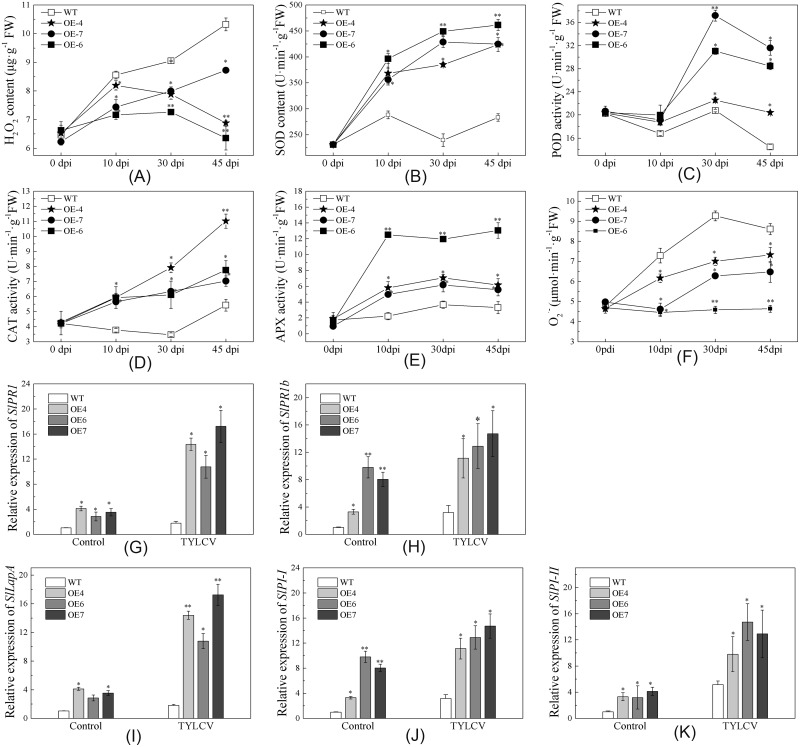
H2O2 accumulation, antioxidant enzyme activity, and defense-related gene expression in wild type (WT) and SlMAPK3-overexpressed (OE4, OE6, OE 7) lines after infection with TYLCV.(A-F) H2O2 accumulation and antioxidant enzyme activity at 0, 10, 30, and 45 dpi. The second and third uppermost leaves were collected from each plant and analyzed for H2O2 content (A), SOD activity (B), POD activity (C), CAT activity (D), APX activity (E), and O2- content (F). Each bar represents the mean of three replicates ± standard error (SE). (G-K) Expression analysis of defense-related genes, SlPR1 (G), SlPR1b (H), SlLapA (I), SlPI-I (J) and SlPI-II (K) at 14 dpi with TYLCV. The SlEF1α gene was used as an internal control [59, 64]. Data are means ± SE (N = 3 to 9) of three independent experiments. Double asterisk (**) and single asterisk (*) indicate significant differences relative to controls at P< 0.01 (Tukey’s test) and P<0.05 (Tukey’s test), respectively.